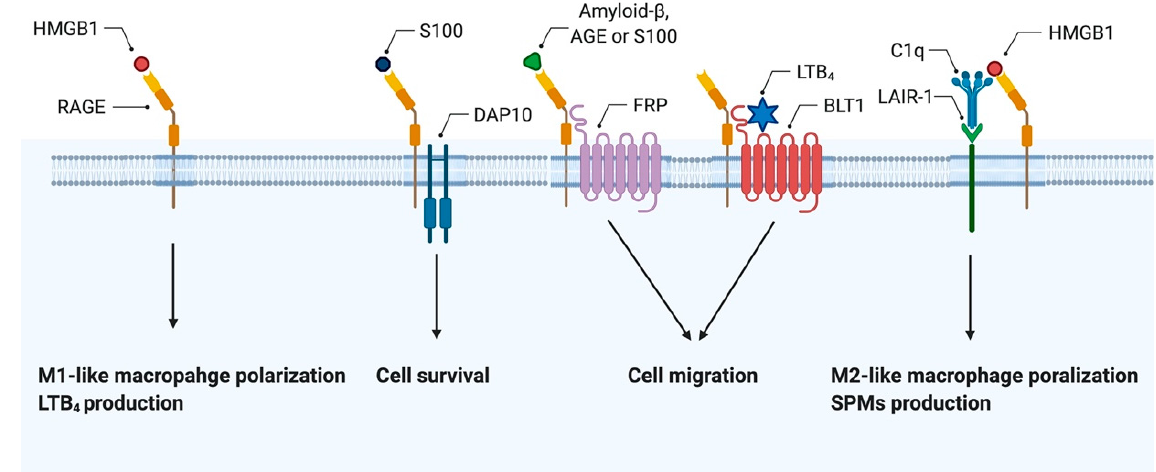
Figure 3. RAGE function as heterodimers. The functional interaction between RAGE and DNAX-activating protein 10 (DAP10) coordinately regulates S100-mediated cell survival. Formyl-peptide-receptors (FPRs) reacts with the broad ligand spectrum through the interaction with RAGE. Leukotriene B 4 (LTB 4 ) receptor 1 (BLT1) interacts with RAGE and induces proinflammatory cytokines and chemokines. HMGB1 promotes leukotriene production, induces interferon regulatory factor 5 in a RAGE-dependent manner. C1q can form a multimolecular signaling complex with HMGB1, RAGE, and Leukocyte-Associated Ig-like Receptor-1 (LAIR-1) and produces specialized pro-resolving lipid mediators (SPMs) and promotes M2-like macrophage polarization, which contributes to the resolution of inflammation.